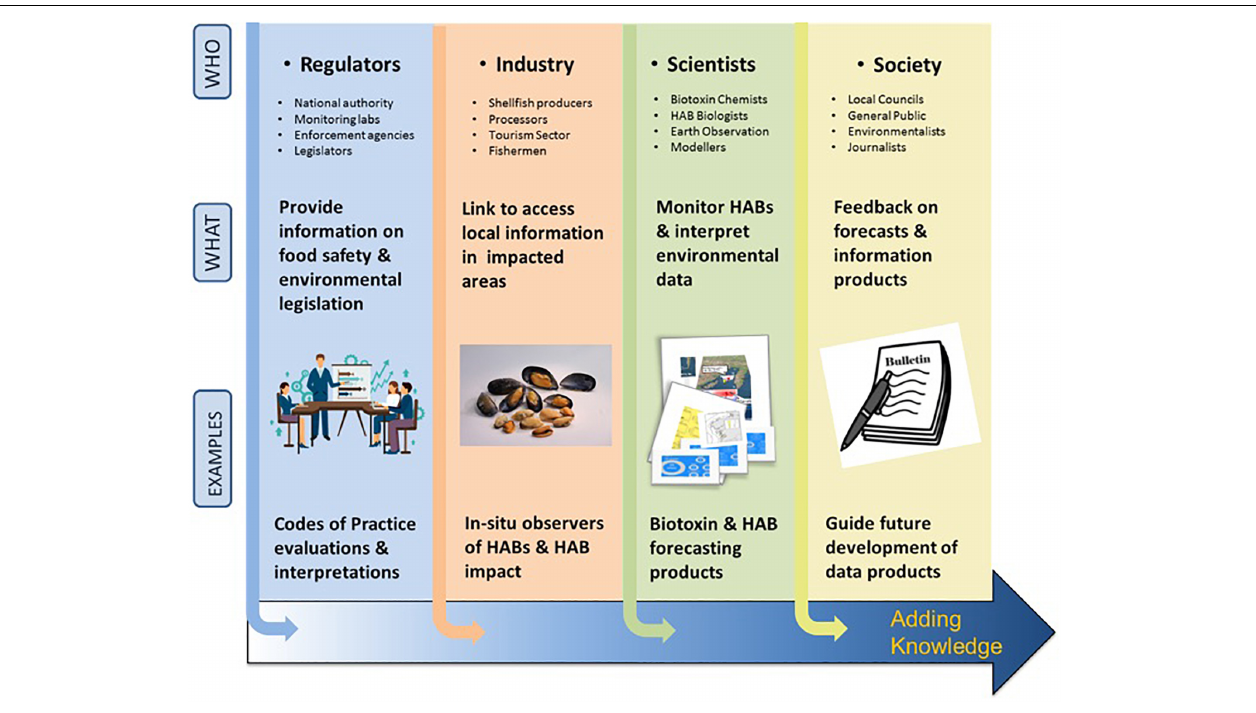
FIGURE 6 | HAB value chain: application of knowledge along the pathway to forecasting bulletin production from different sectors, regulators, industry, scientists and society and examples of the knowledge they provide. “Users” of the products along the chain are vital as they provide expertise to determine the HAB forecast and other data-derived products